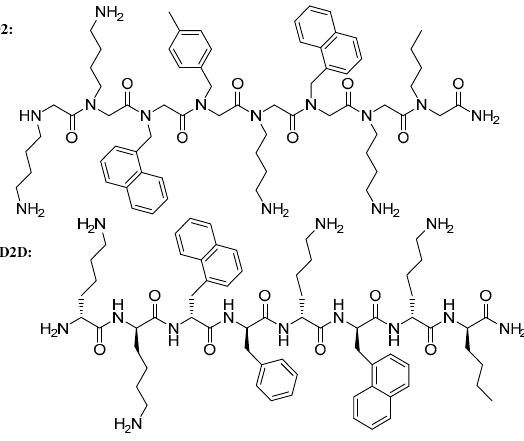
Figure 1. Lead compound D2 and its most active analogue D2D.